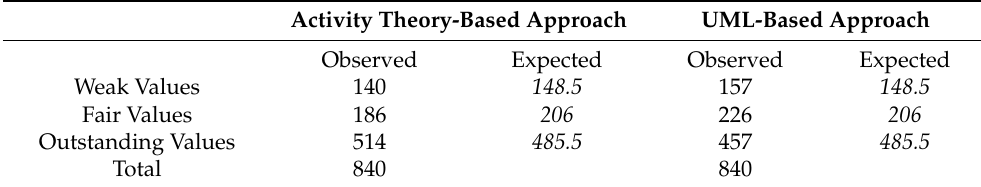
Table 6. Values grouping and distribution between observed and expected results for the Chi-square